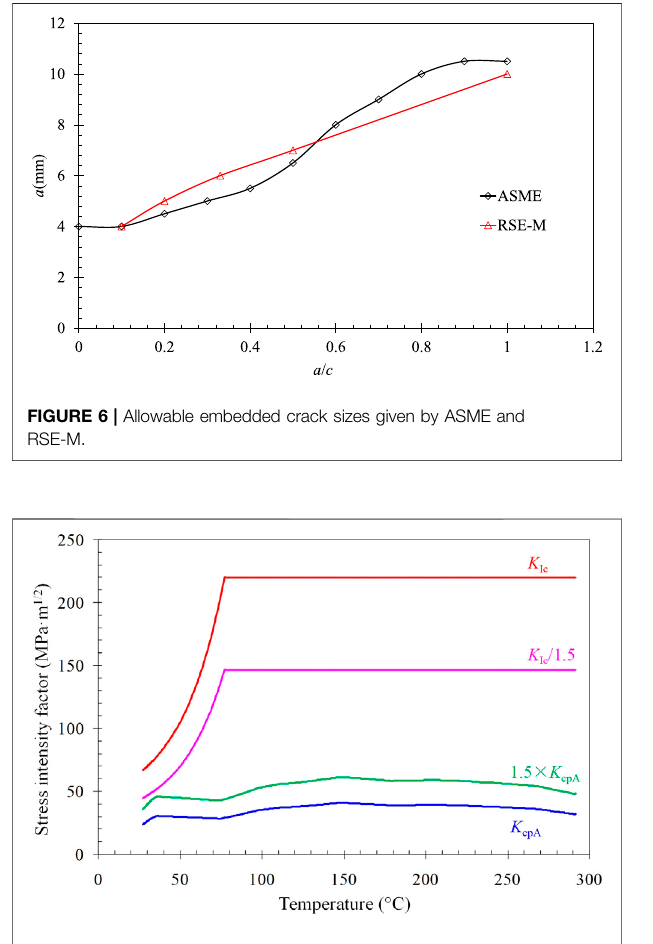
FIGURE 7 | Stress intensity factors of underclad semi-elliptical defects ( a (cid:3) 28.0 mm, c (cid:3) 280.0 mm) under the most dangerous condition.